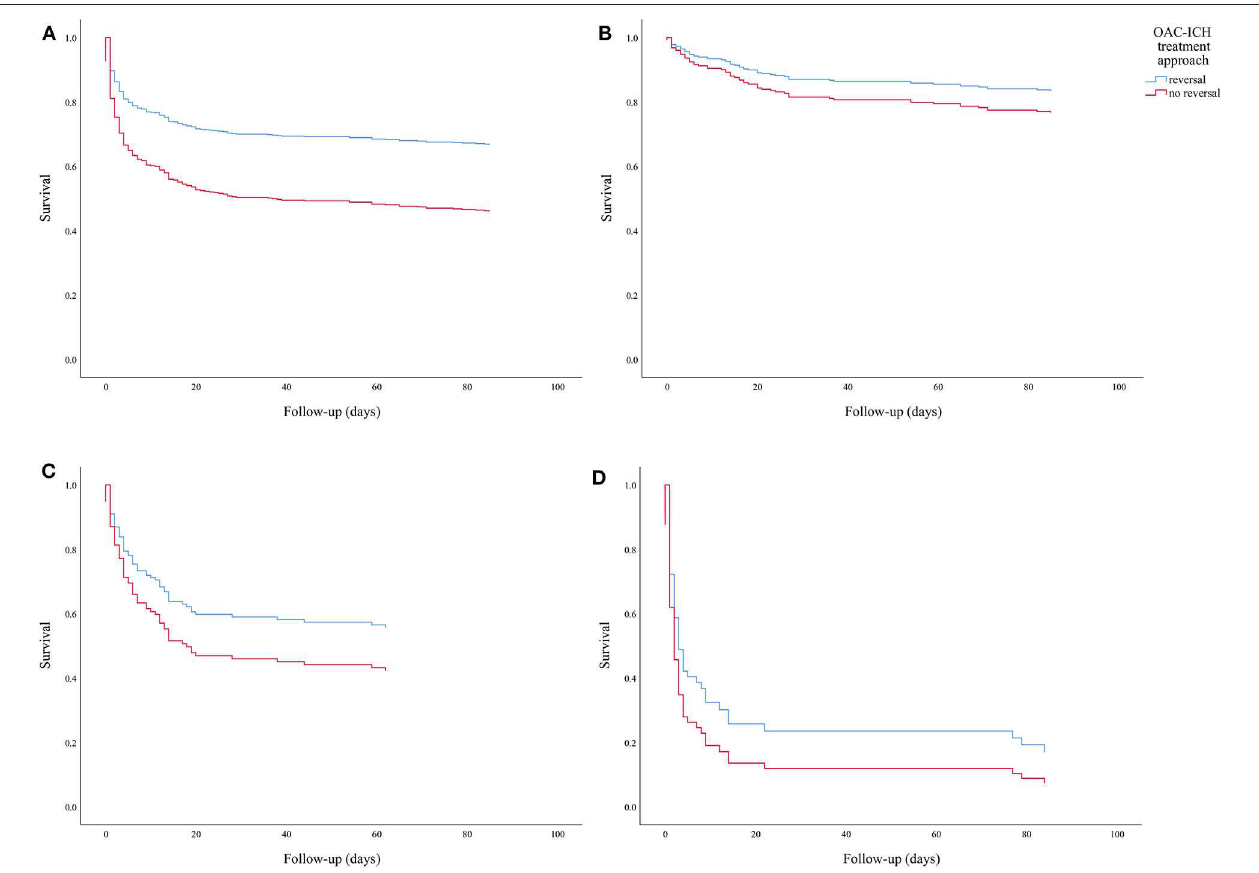
FIGURE 1 | (A) Simple analysis showing Kaplan-Meier survival curve of 90-day cumulative survival following OAC-ICH comparing patients with reversal treatment vs. non-OAC reversal patients ( n = 572). (B–D) Survival curves based on multivariate analysis stratified for level of consciousness, comparing 90-day cumulative survival following OAC-ICH in patients receiving reversal treatment vs. non-OAC reversed patients. State of consciousness according to graph is as follows: (B) alert ( n = 316), (C) drowsy ( n = 128), (D) comatose ( n =